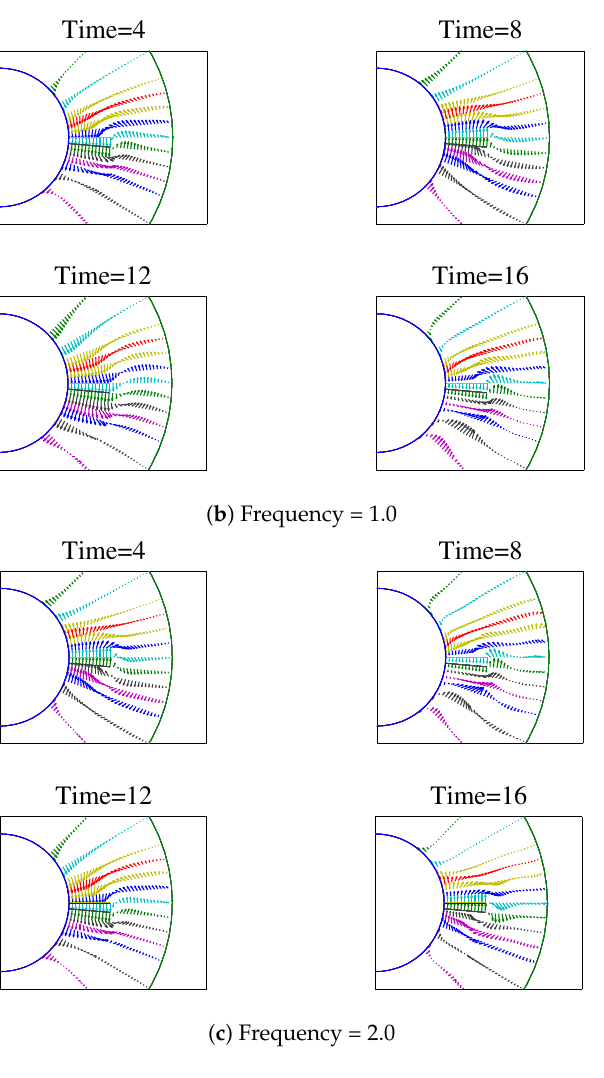
Figure 3. Velocity field in the vicinity of the plate at various times for width/gap = 0.4. ( a ) Frequency = 0.5; ( b ) Frequency = 1.0; ( c ) Frequency = 2.0.